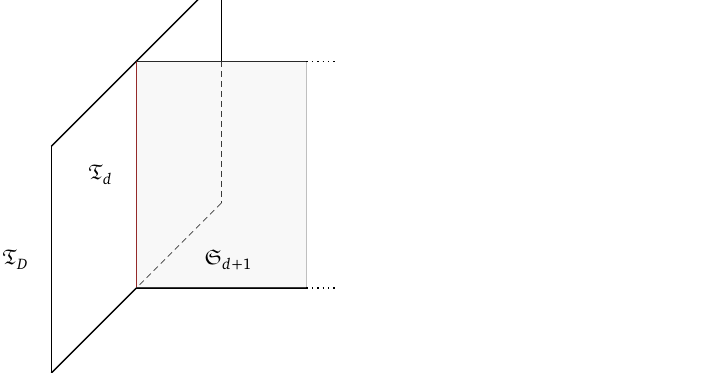
in absolute theory T d